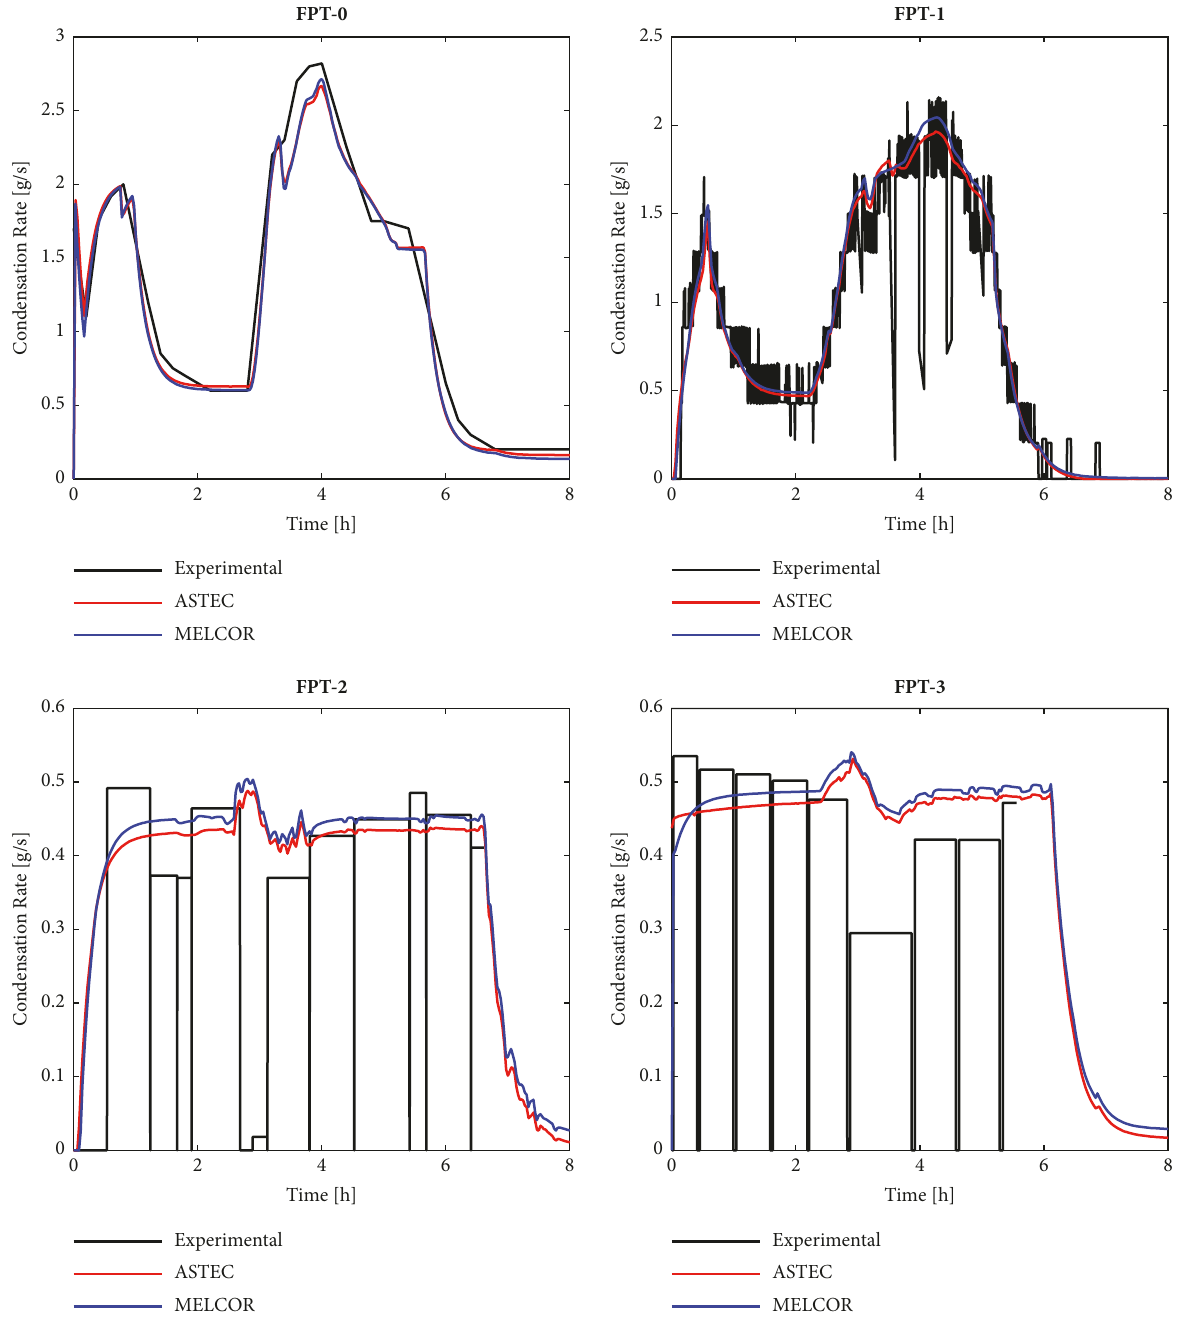
Figure 8: Total condensation rate onto the wet condenser’s surface during the degradation phase of the Ph´ebus FPT tests.